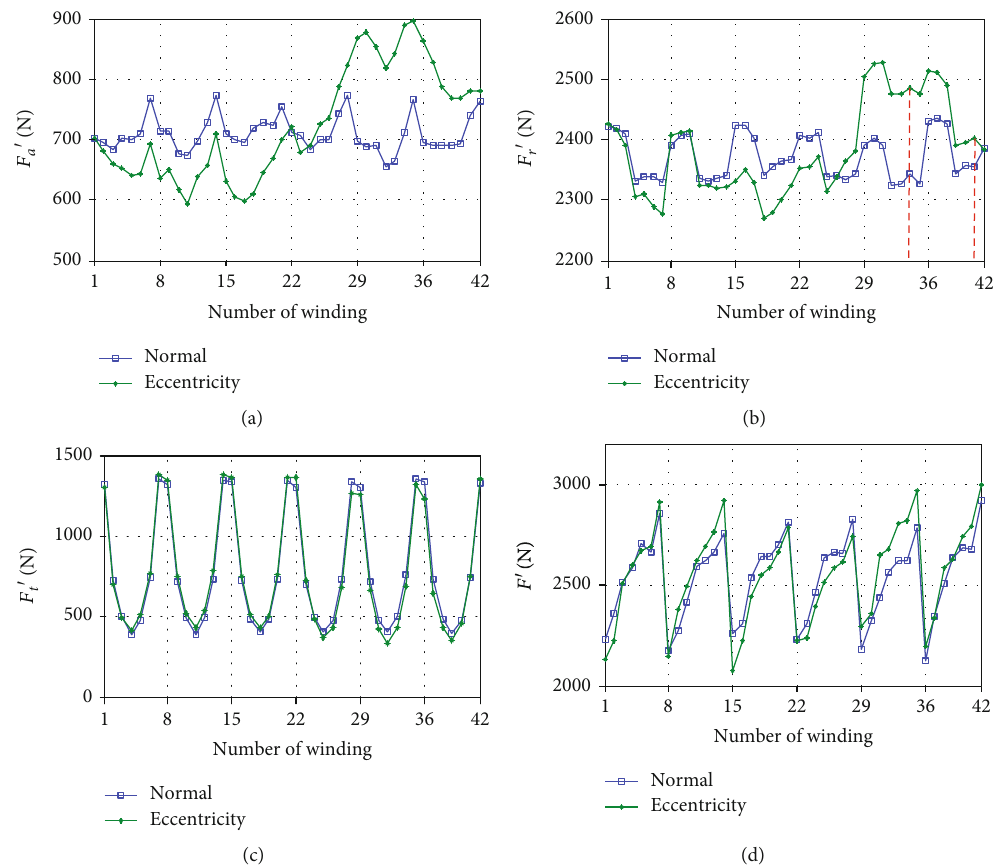
Figure 6: 2nd harmonic amplitudes of electromagnetic forces: (a) axial, (b) radial, (c) tangential, and (d) resultant